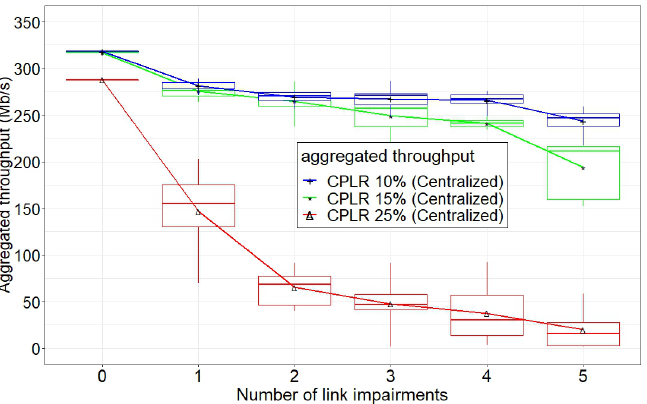
Figure 8. Aggregated throughput behavior of centralized network operation during data plane link failures for various times under unreliable control plane conditions in a 9-node grid network.